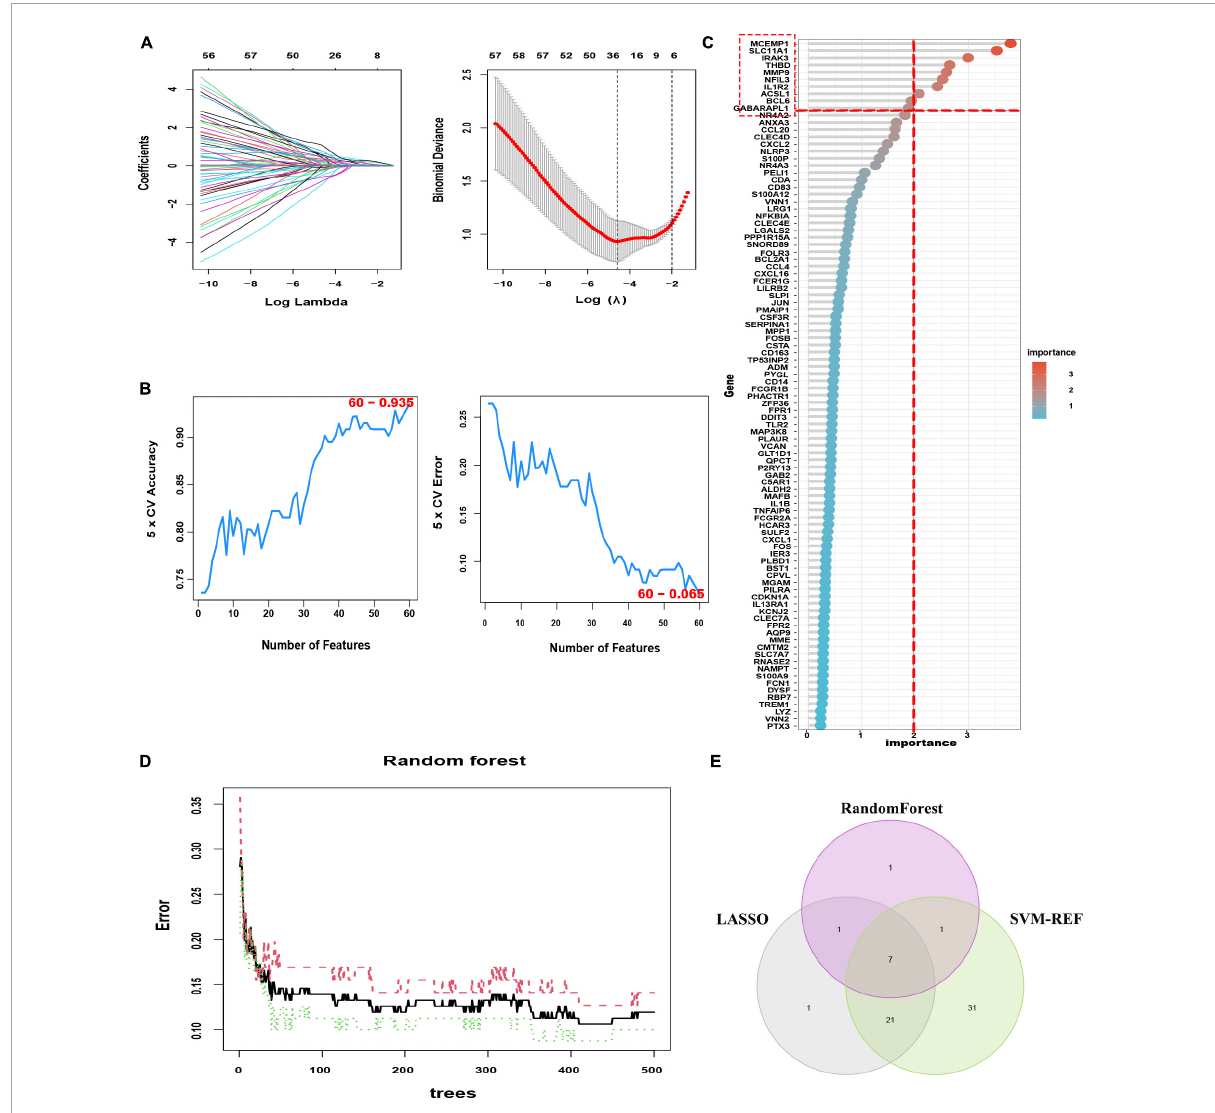
FIGURE5 Three machine learning algorithms were integrated to identify the optimal feature genes. (A) LASSO coefficient profiles of the candidate optimal feature genes and the optimal lambda was determined when the partial likelihood deviance reached the minimum value. Each coefficient curve in the left picture represents a single gene. The solid vertical lines in right picture represent the partial likelihood deviance, and the number of genes ( n = 30) corresponding to the lowest point of the cure is the most suitable for LASSO. (B) The SVM-RFE algorithm was used to further candidate optimal feature genes with the highest accuracy and lowest error obtained in the curves. The x -axis shows the number of feature selections, and the y -axis shows the prediction accuracy. (C) Relative importance of overlapping candidate genes calculated in random forest (Top 10 genes’ importance > 2). Importance indexes on the x -axis and genetic variables are plotted on the y -axis. (D) Random forest for the relationships between the number of trees and error rate. The x -axis represents the number of decision trees and the y -axis is the error rate. (E) Venn diagram showing the seven optimal feature genes shared by LASSO, Random Forest, and SVM-REF